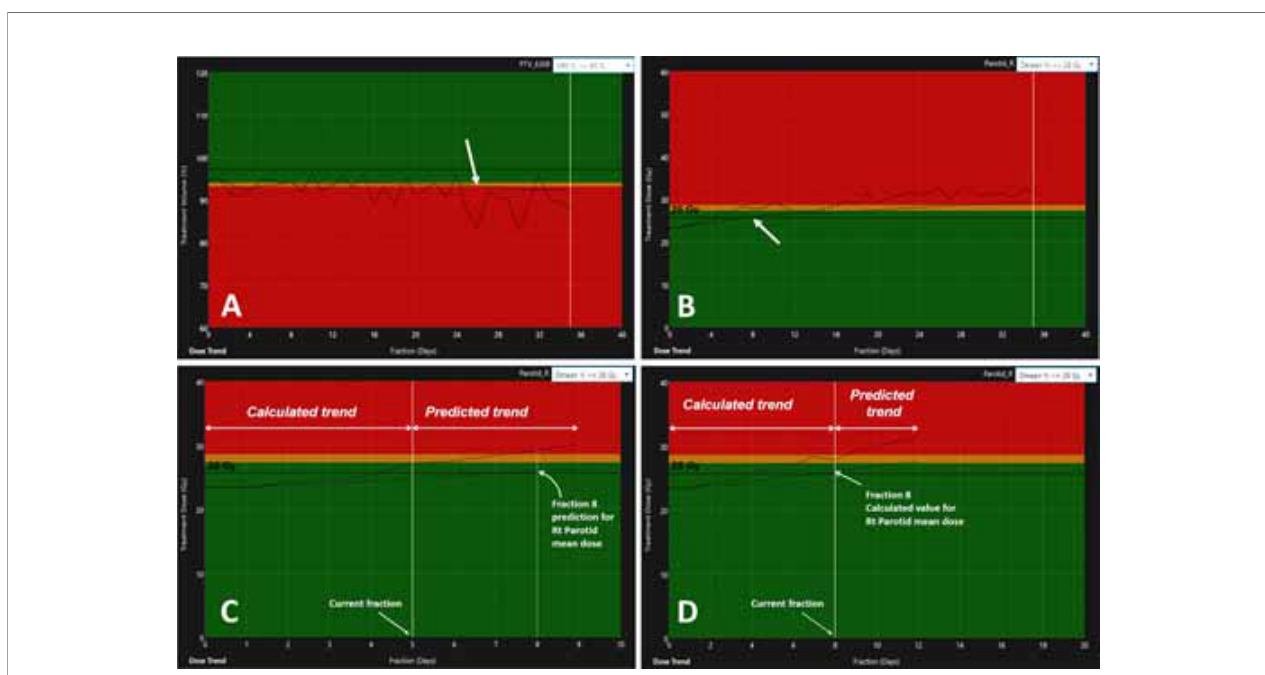
FIGURE 4 | Variation of dosimetric parameters over the full treatments for (A) the V 95 trend of PTV63 (study 118) and (B) the increase in PG D mean for the right PG (study 81). The dashed lines indicate the DP day value estimated from the day of treatment DVH day . The dotted line represents the variation of the DP sum estimated from the cumulative DVH sum . The arrows indicate the fraction at which the DP sum values reached their respective adaptation thresholds: V 95 < 93% at fraction 26 for PTV63 (A) and PG D mean > 26 Gy at fraction 8 (B) . Panels (C, D) illustrate the trend prediction in DP sum for the right PG. The data to the left of the current fraction represent calculated values from daily deformed anatomy. The data to the right predict the variations of the DP day and DP sum for the next four fractions.